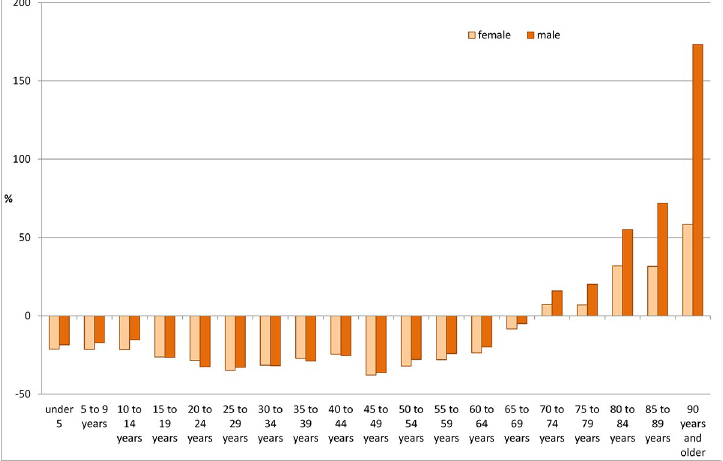
Fig 7. Change in the number of treatment days in 2040 compared to 2015 by age group and sex, scenario S12. Source: Population projection 2016–2040 [21], own calculations.